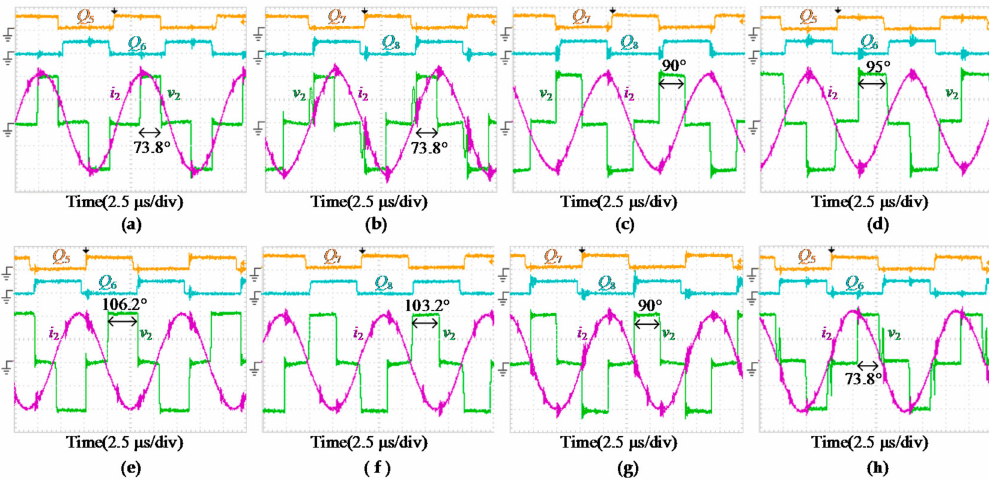
Figure 11. Experimental results of the eight kinds of dead-time effect in the DAB WPT system. ( a ) Region 1; ( b ) Region 2; ( c ) Region 3; ( d ) Region 4; ( e ) Region 5; ( f ) Region 6; ( g ) Region 7; ( h ) Region 8. Q 5 – Q 8 : 5 V/div; i 2 : 5 A/div; v 2 : 50